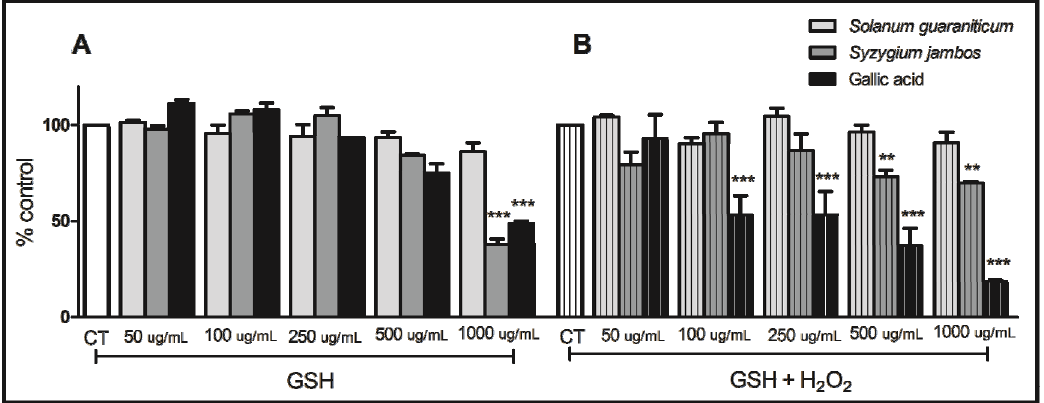
Figure 2. Thiol peroxidase-like activity of aqueous extracts tested in the absence of H O ( B ). Data are reported as mean ± SEM ( n = 3) and assessed by and in the presence of H 2 2 one way ANOVA followed by Duncan Multiple Comparison post hoc test. (**) and (***) denotes p < 0.001 and p < 0.0001, compared to respective controls (CT).